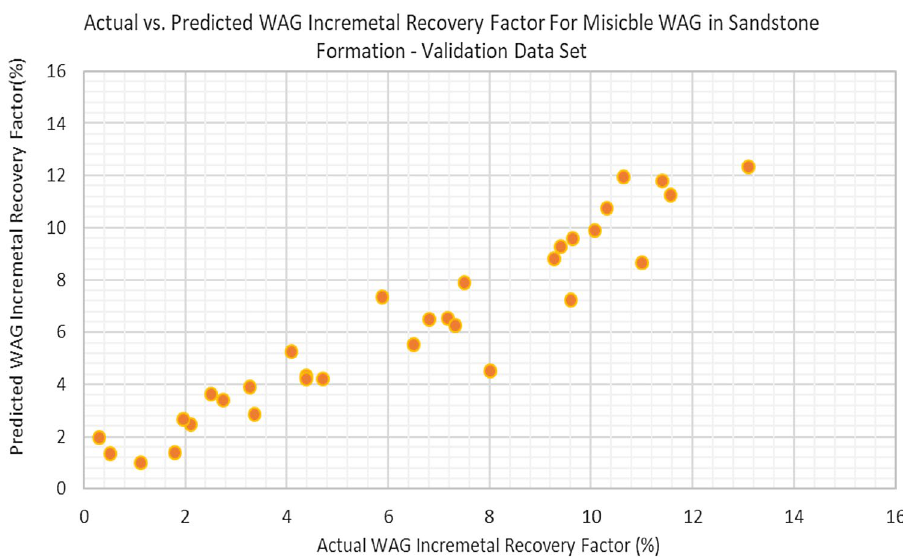
Fig. 10 Regression WAG incre- mental recovery factor predic- tion model validation results for immiscible WAG in sandstone